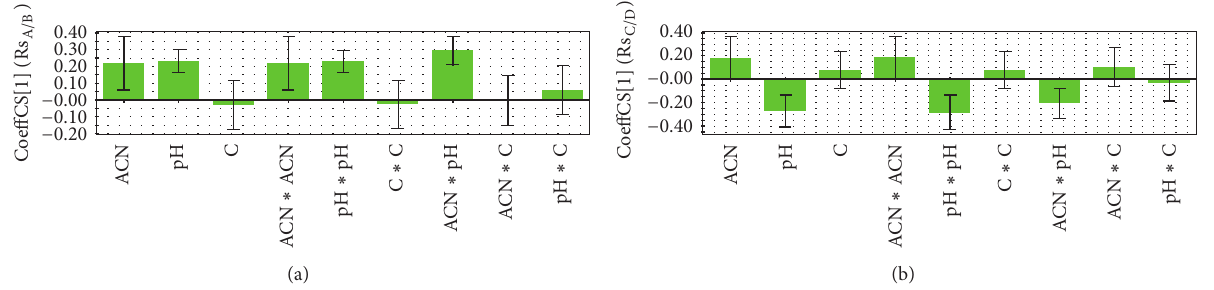
Figure 3: Plot of coefficients for the response variables: (a) Rs A / B and (b) Rs C / D .